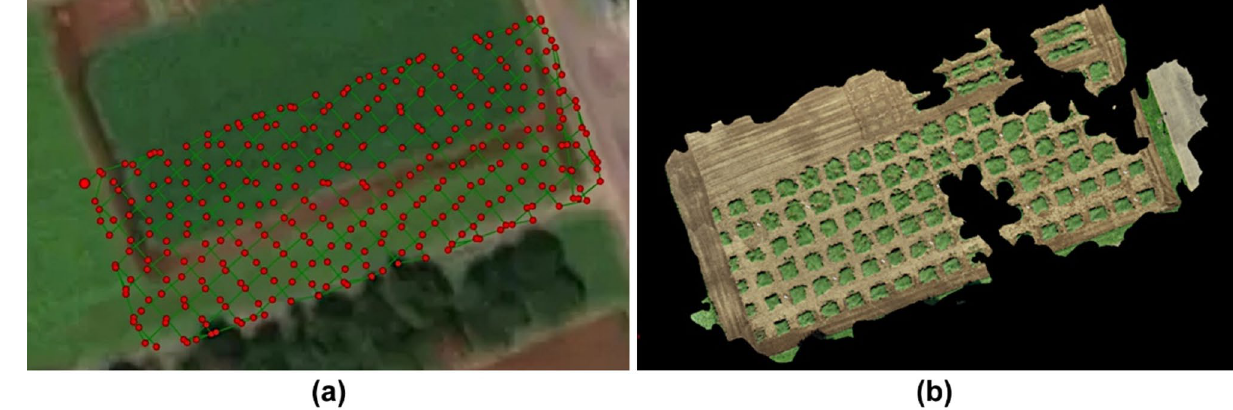
Figure 2. ( a ) Flight route of Phantom 4 RTK and ( b ) 3D reconstruction result by Pix4Dmapper for 332 field images and their GNSS data obtained by Phantom 4